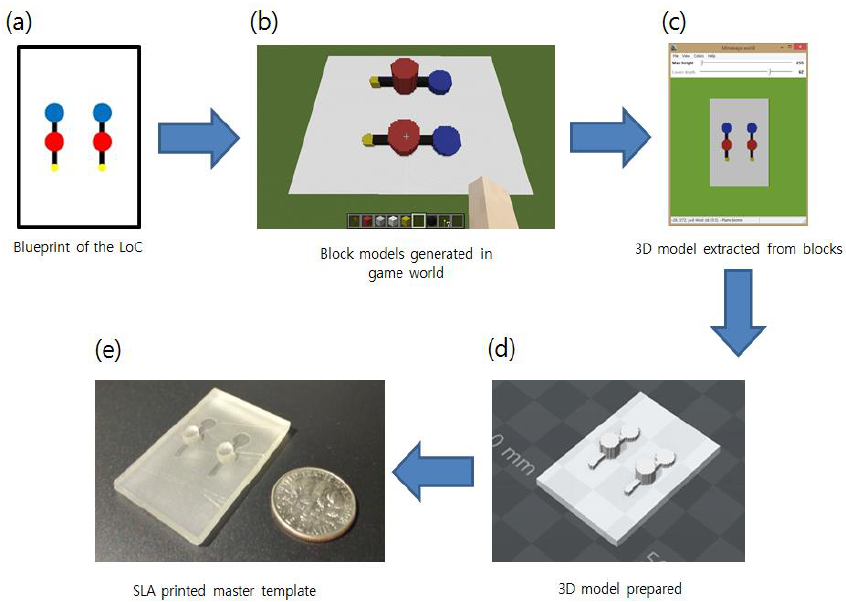
Figure 1. The processing flow of the MineLoC: ( a ) blueprint image with the different colors describes the function of the block; ( b ) block structure in the game world is generated based on the blueprint; ( c ) block structure is extracted using a freeware program; ( d ) 3D model is prepared for additive manufacturing; and ( e ) master template is printed using 3D printer.